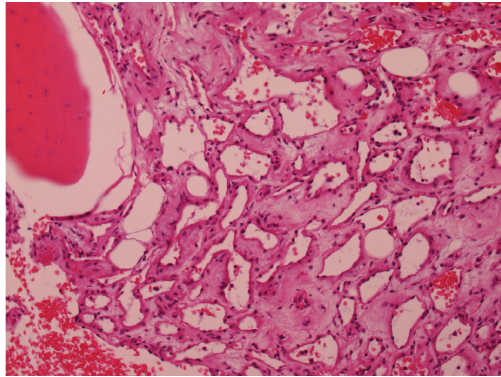
Figure 2: Histology demonstrating multiple tiny fragments of tra- becular bone and marrow tissue being replaced by a mixture of fat, loose fibrous connective tissue, and thin walled multiple vascu- lar channels which are suggestive of a benign intraosseous heman-